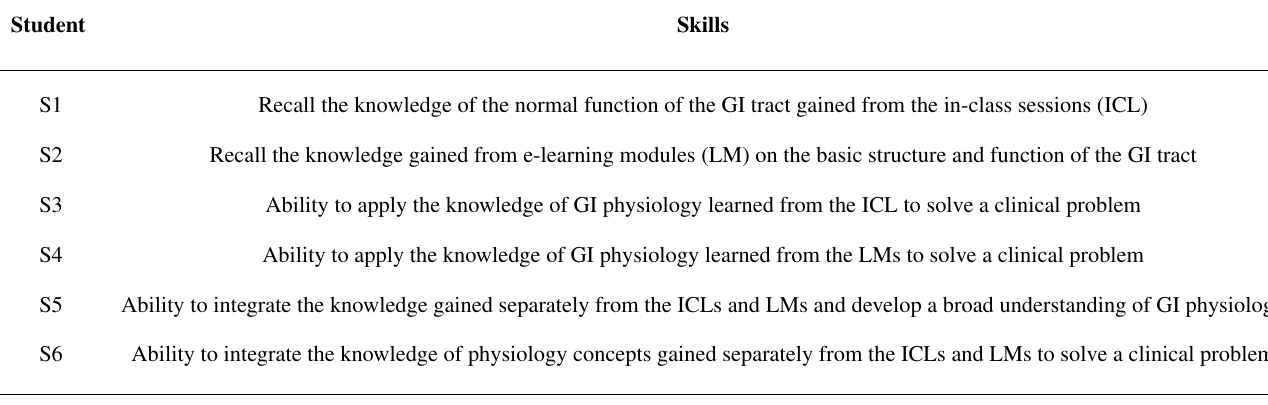
Table 1. The various skills which the students must possess to correctly answer the assessment items from GI physiology that appeared on the course exam.